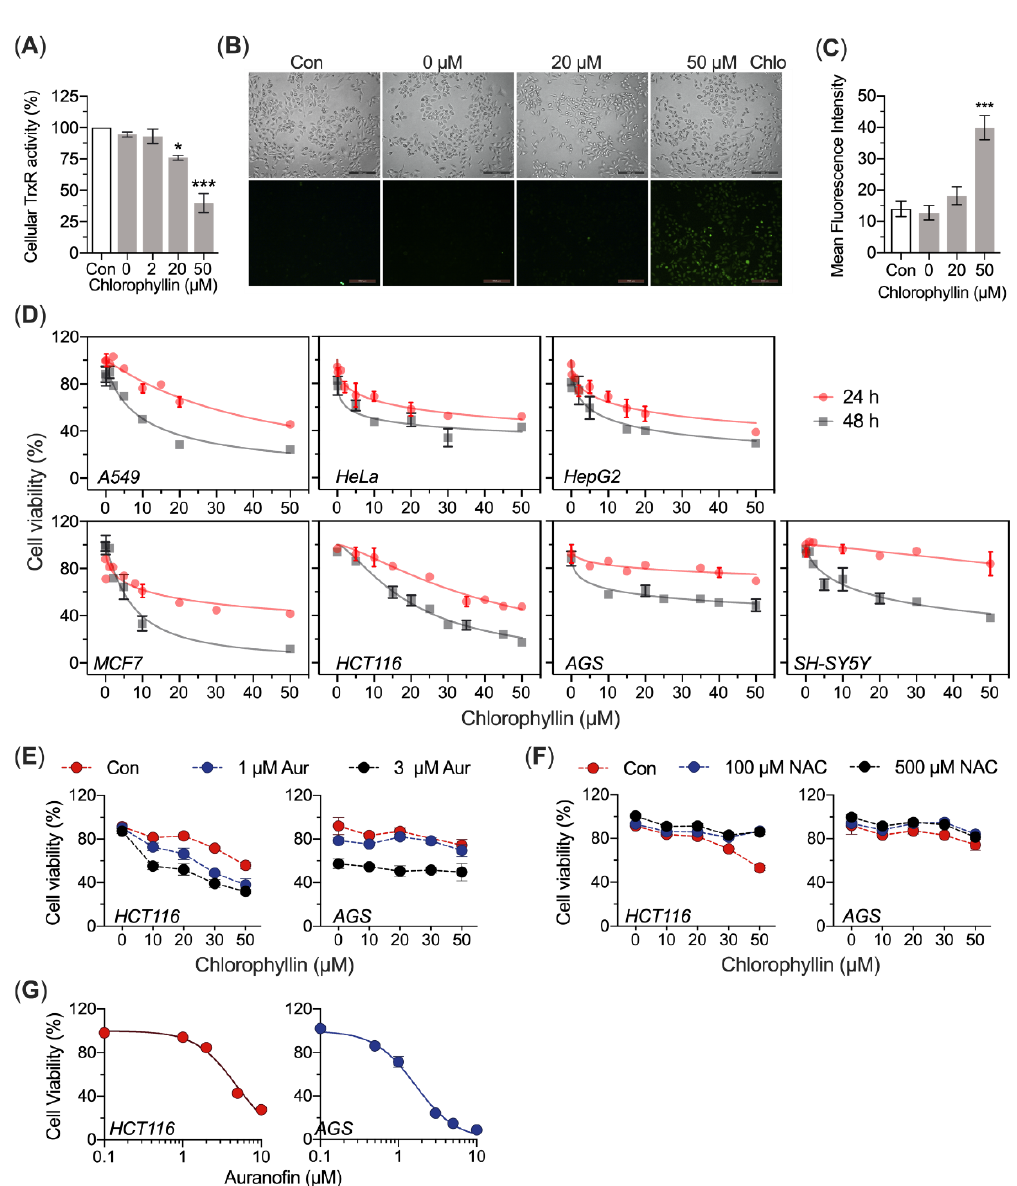
Figure 6. Chlorophyllin inhibits the cellular TrxR activity by using cancer cell lines. ( A ) Chlorophyllin inhibits the cellular TrxR activity. HeLa cells were harvested by using RIPA buffer on ice, then the cellular TrxR activity was determined by end-point Trx-coupled insulin assay and the protein concentration was determined using a BCA kit. ( B ) Chlorophyllin induces ROS production in HeLa cells. HeLa cells were treated with chlorophyllin for 12 h. After incubation, the cellular ROS were detected by using DFCH-DA. Phase-contrast (top) and fluorescence (bottom) images were acquired by fluorescence microscopy. The mean fluorescence intensities from ( B ) were quantified by ImageJ TM (NIH, USA) and shown in ( C ) with the treatment of chlorophyllin up to 50 µM. ( D ) The cell viability was determined by MTT. Chlorophyllin induces cancer cell death by inhibiting TrxR1. Human A549 cells, HeLa cells, HepG2 cells, MCF7 cells, HCT116 cells, AGS cells and SH-SY5Y cells were incubated with chlorophyllin at the indicated concentrations for 24 h and 48 h, respectively. ( E , F ) Cell viability of HCT116 cells and AGS cells exposed to chlorophyllin alone or in combination with auranofin (2.5 h pre-treatment) or NAC (24 h co-treatment). ( G ) Cytotoxicity of auranofin on HCT116 cells and AGS cells. Cells were treated with auranofin for 2.5 h, and the cell viability was determined using MTT assay. ( * p < 0.05 and *** p < 0.001).